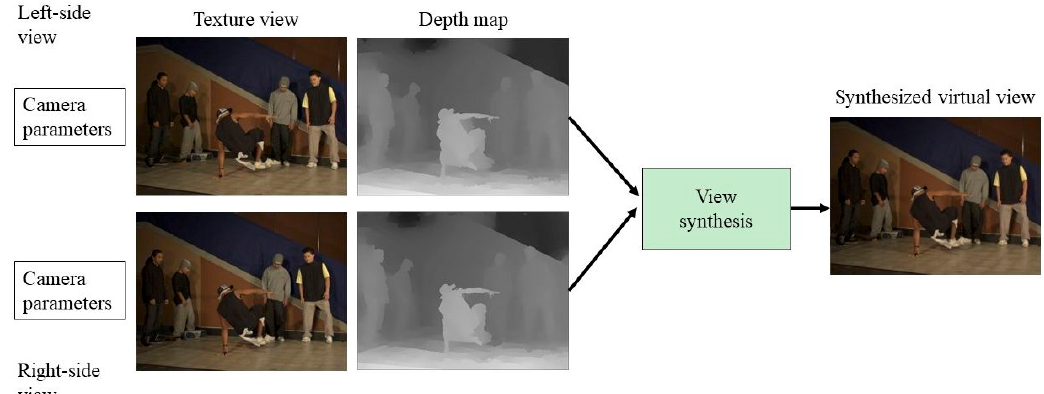
Figure 2. Profile of depth image-based rendering (DIBR) virtual view synthesis.